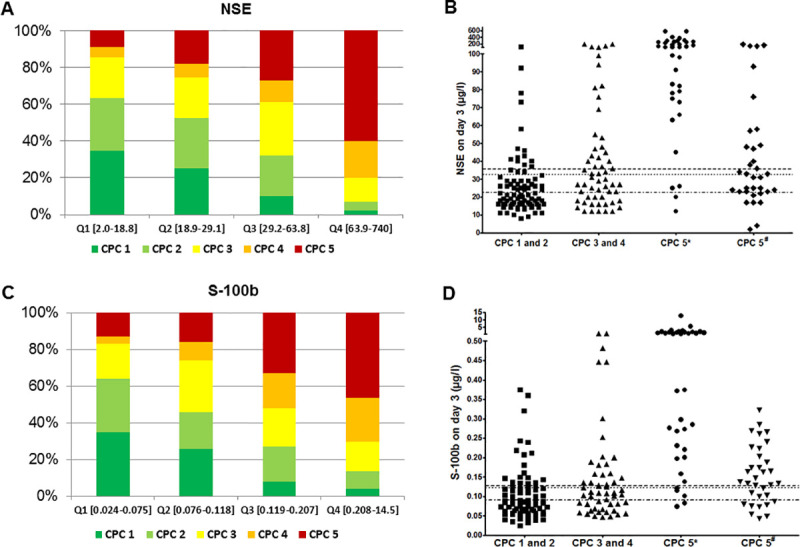
Distribution of CPC-classes according to interquartiles of NSE and S-100b and relation to cut-off values: Proportions of CPC classes according to the interquartile distributions of NSE (A) and S-100b (C), respectively, and scatter plots of survivors with good (CPC 1 and 2) and poor neurological outcome (divided in CPC 3 and 4 and CPC 5 separated by *anoxic and #other causes of death) for NSE (B) and S-100b (D) with cut-off values for mortality (dashed line) and poor neurological outcome (dotted line) and poor neurological outcome of survivors (dotted and dashed line).